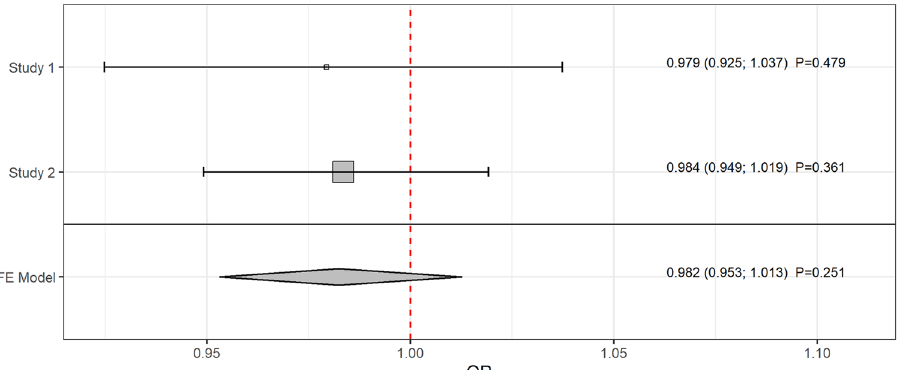
Fig. 2 Combined causal radial IVW estimator with second-order weights from a fi xed effect meta-analysis for the causal effect of genetically predicted in fl ammatory bowel disease on Parkinson ’ s disease. The shown estimates are given as odds ratios (ORs) and 95% con fi dence intervals and can be interpreted as the average change in the outcome per 2.72-fold increase in the prevalence of the